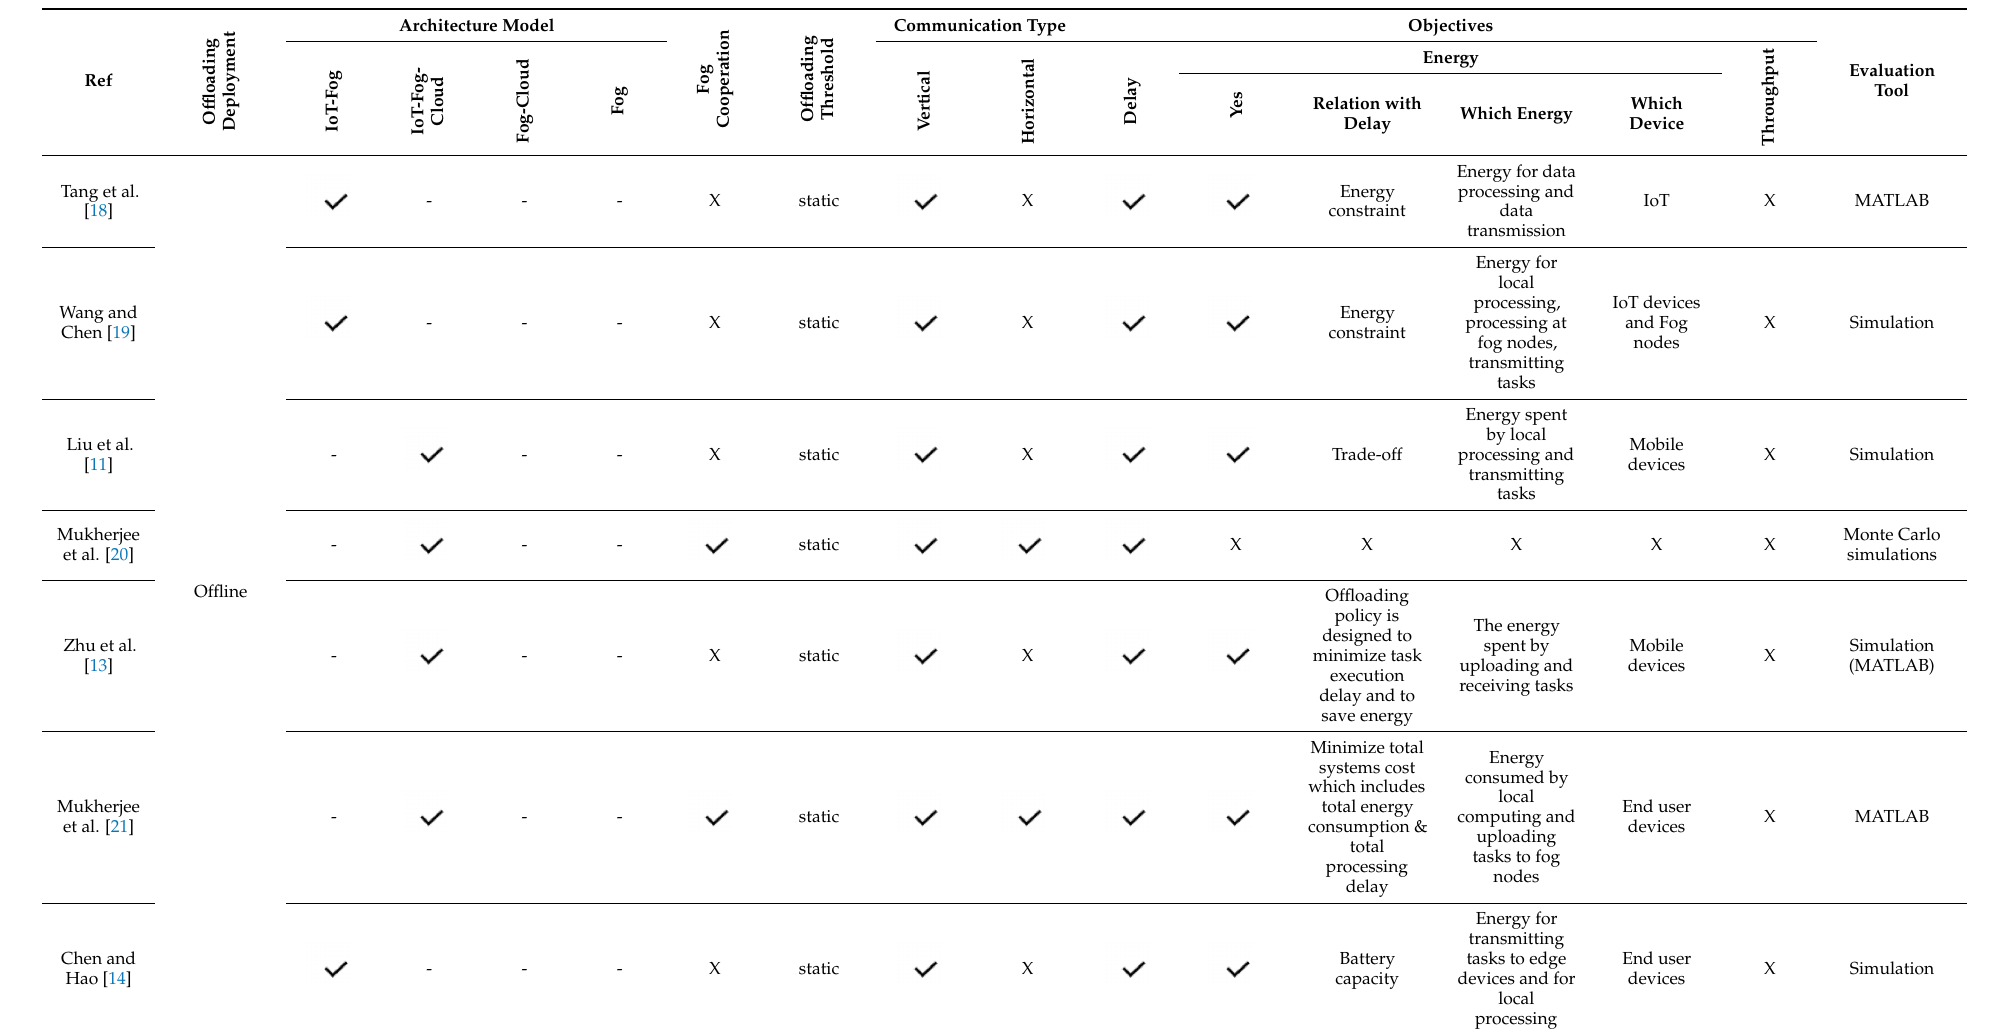
Table 1. Computational Offloading State-Of-Art